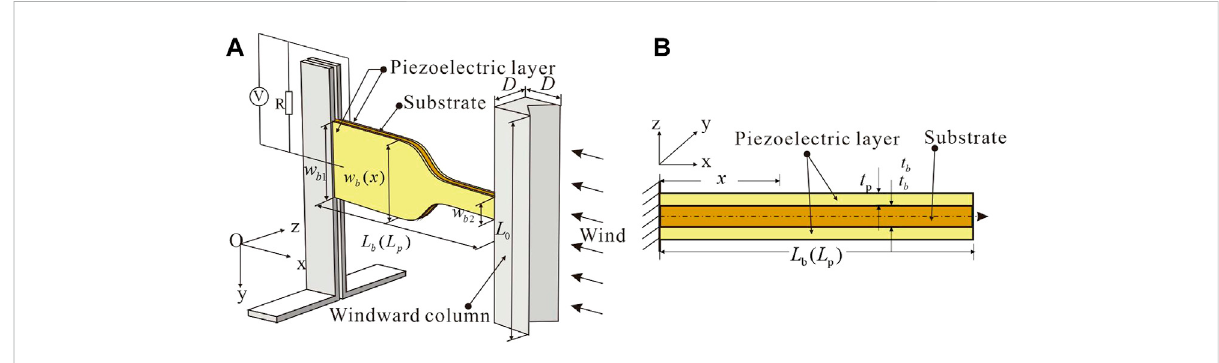
FIGURE 1 (A) Schematic diagram of the variable cross-sectional energy harvester. (B) Top view of the piezoelectric cantilever